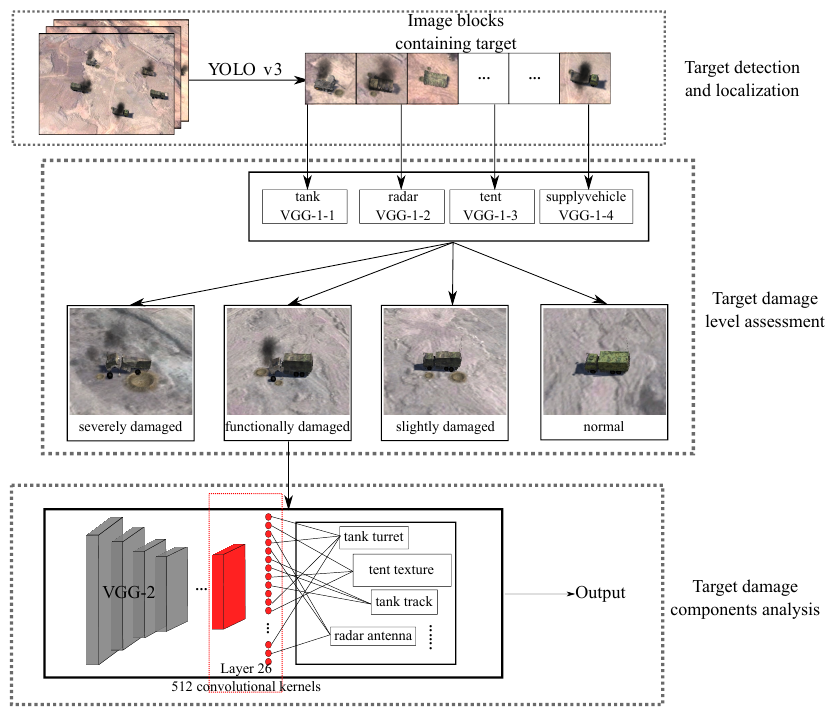
Figure 1. The process of mobile ground target detection and damage assessment by patrol